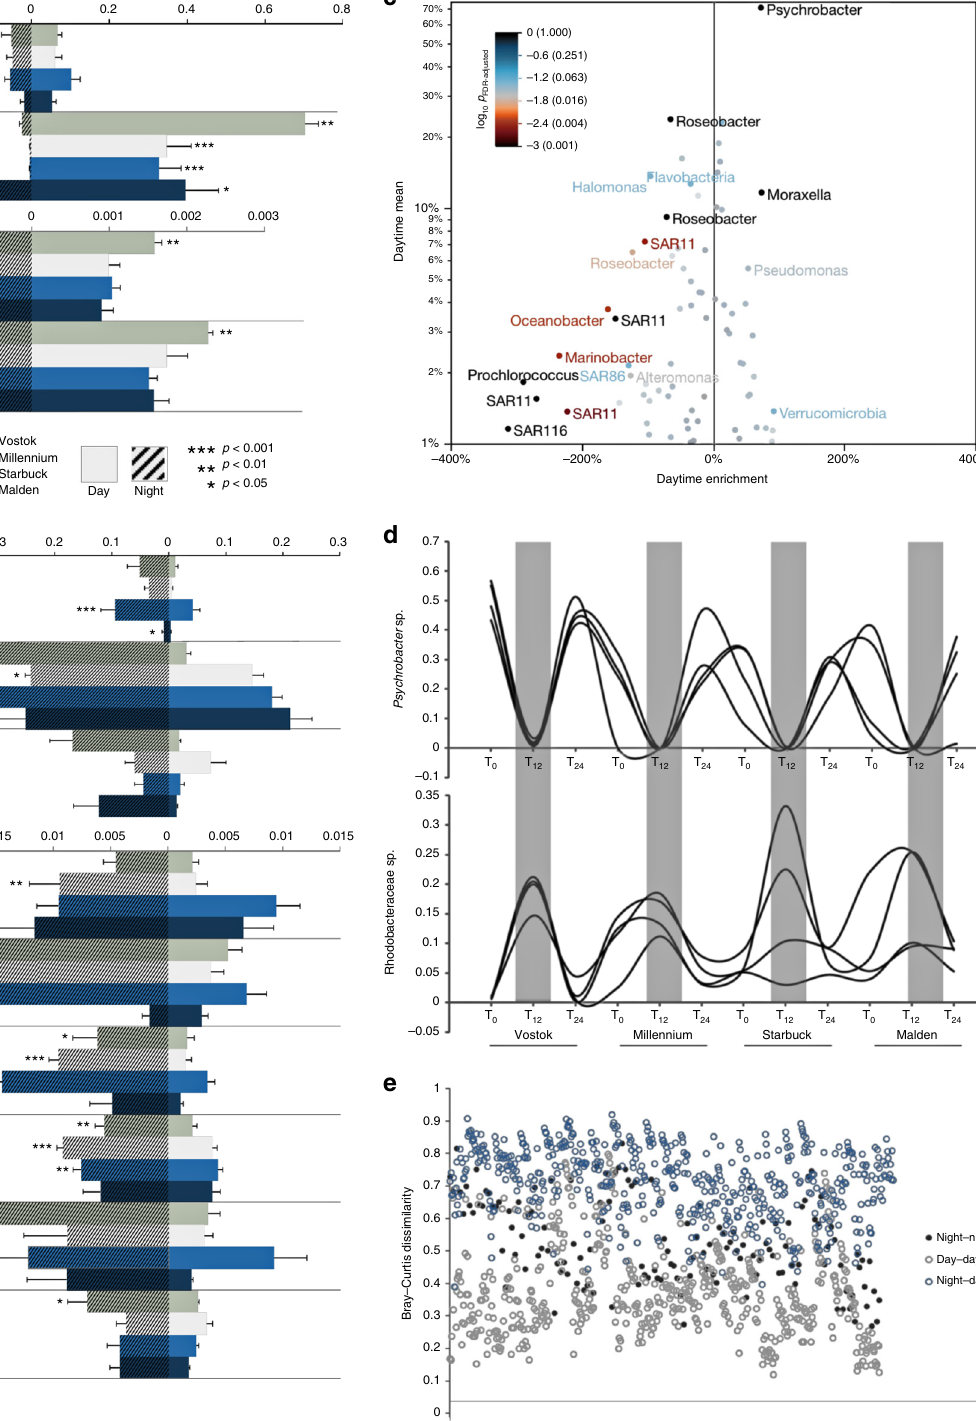
Fig. 2b). There were several signi fi cantly enriched Alphaproteo- bacteria and Gammaproteobacteria families ranging from 1% to 5% of the community including Rhizobiaceae, Rhodospirillaceae, and Halobacteriovoraceae, and Oceanospirillaceae, Pseudoalter- omonadaceae, and Vibrionaceae, respectively (Fig. 2b; Supple- mentary Table 2). Changes in the relative abundance of